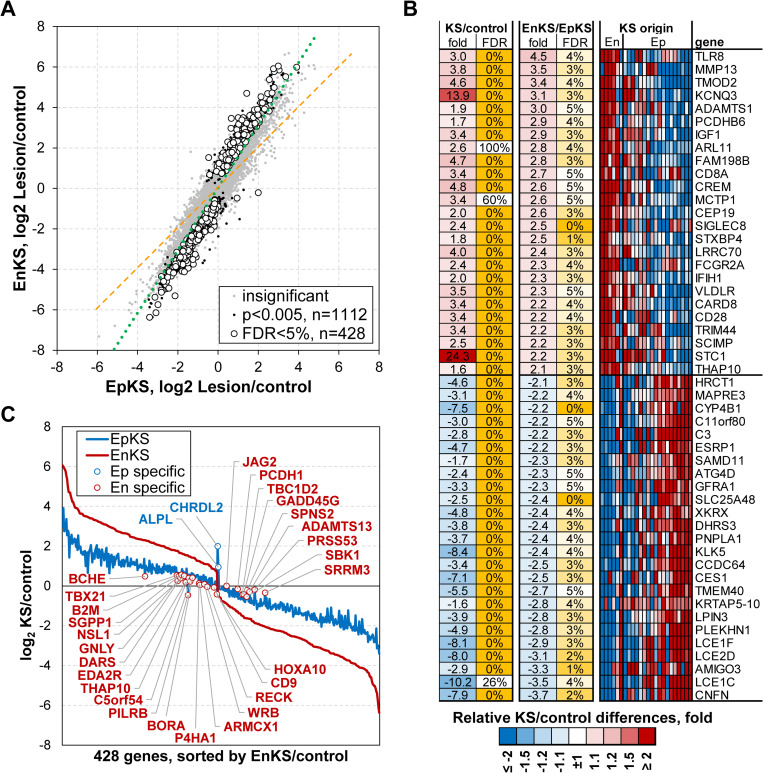
Comparison of transcriptome profiles (KS lesion vs control) between EpKS and EnKS patients.(A) A scatter plot comparing transcriptome profiles between EpKS and EnKS patients. Green dotted line denotes actual regression line; orange dotted line denotes expected relationship without any difference between groups. Grey dots denote genes whose expression was not significantly different between EpKS and EnKS patients. Black dots denote genes whose expression was nominally significantly different between EpKS and EnKS patients at P = 0.005 (N = 1112). Filled circles denote genes whose expression was significantly different between EpKS and EnKS patients at FDR<5% (N = 428). FDR–False discovery rate. (B) Heatmap of top coding genes that are significantly different in KS lesion vs controls and significantly more dysregulated in EnKS than EpKS patients. (C) Comparison of KS lesion vs control differences for 428 genes that are significantly different between EnKS and EpKS indicates that majority of genes are not uniquely dysregulated in endemic KS, but that dysregulation is more extreme in EnKS compared to EpKS. White filled circles highlight 29 genes that had at least 1.5-fold KS lesion/control fold change in one group, but less than 50% of the fold in another group. EnKS–Endemic Kaposi’s sarcoma, EpKS–Epidemic Kaposi’s sarcoma.